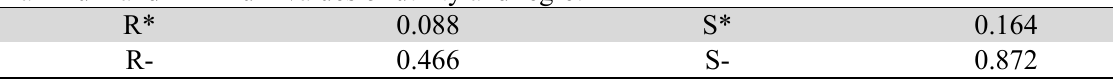
Maximum and minimum values of utility and regret